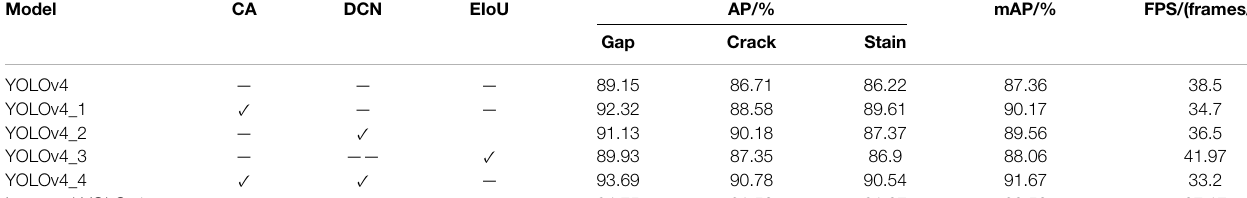
TABLE 2 | Effects of different modules on model performance. Model